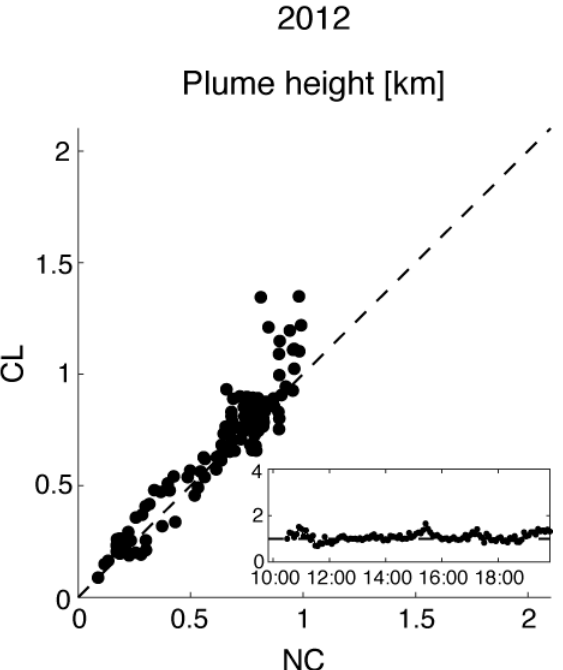
Figure 13. As in Figure 9, but for the 2012 case.